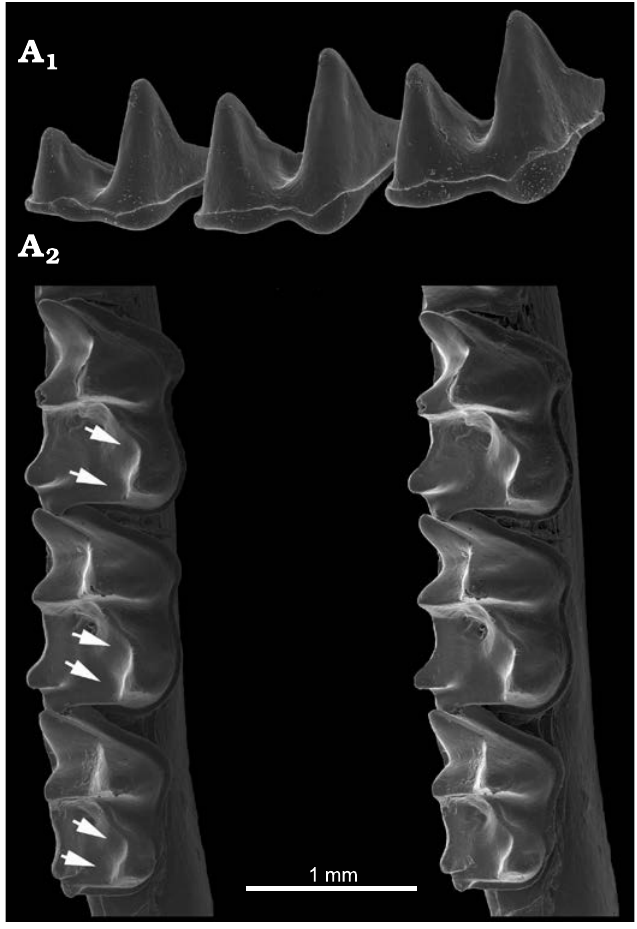
Fig. 11. Miniopterid bat Miniopterus australis Tomes, 1858 (USNM 590280) from Malaysia, Recent. Right lower molars in anterolabial view (A 1 ) show- ing no carnassiform notches in the cristids obliqua; note that the entoconids are partly visible in the background immediately behind the cristid obliqua in each molar); and in occlusal view (A 2 , stereopair) showing well-developed accessory troughs (arrows) in